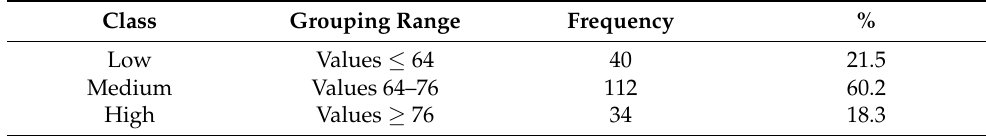
Table 13. Percentage of sustainability level by grouping ranges.